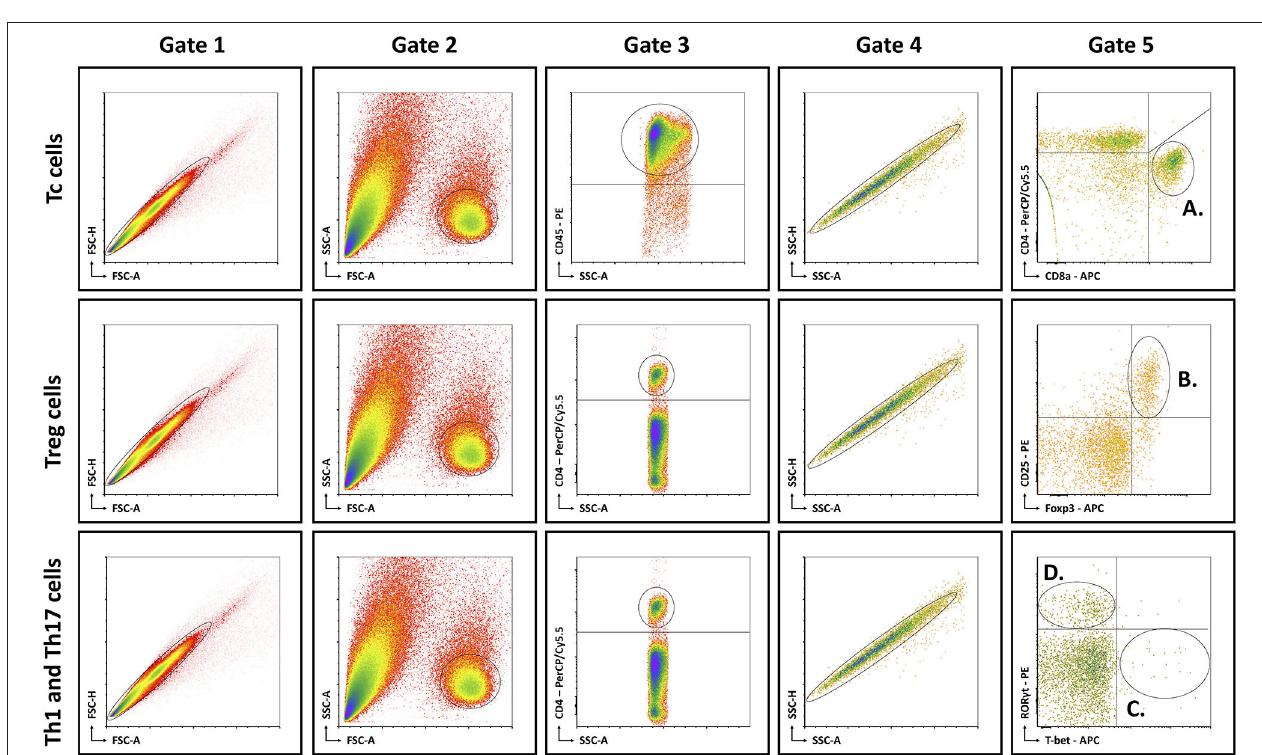
FIGURE 1 | Schematic overview of flow cytometric gating strategy for the identification of (A) Tc cells, (B) Treg cells, (C) Th1 cells, and (D) Th17 cells in liver, VAT, SAT, spleen, and blood. Lymphocyte populations were determined by FSC-A and SSC-A. Doublets and triplets were filtered out twice by plotting area to height for both FSC and SSC. Concerning the fluorochrome-stained cells, positive populations were defined as being above the 99th percentile of FMO staining, indicated by the quadrants. -A, area; FSC, forward scatter; FMO, fluorescence minus one; -H; height; SSC, side scatter; Tc, cytotoxic T; Th1, T helper 1; Th17, T helper 17; Treg, regulatory